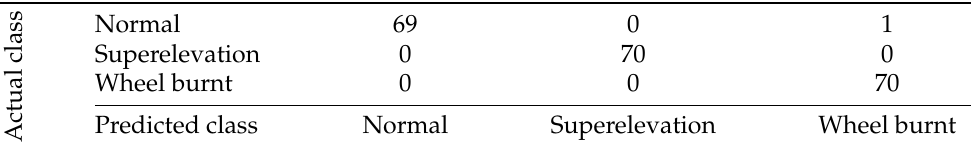
Table 8. Confusion matrix of LSTM 8.5 s split, augmented training dataset and un-augmented test dataset.